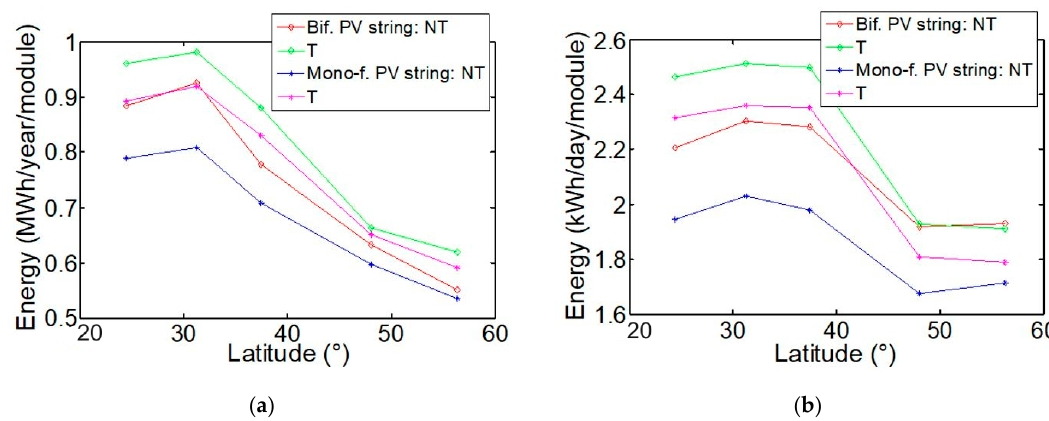
Figure 10. Energy produced, normalized per module, as a function of the latitude, for the cases of: 30-module mono-facial PV stings (i.e., illuminated only from the front side) and 30-module bifacial PV strings, without any solar tracker (fixed string, with module tilt angle equal to the considered latitude) (see NT symbol in the legend) or with uniaxial horizontal solar tracker (see T symbol in the legend), as calculated by the proposed model (considering the five locations specified in the main text): ( a ) specific energy per year; ( b ) specific energy per day, by considering day n. 79 (spring equinox) of the year 2018. For the cases of fixed PV string and of string with tracker, the parameters YB and XA , respectively, were set equal to 10 m (saturation condition of the perimeter effects).